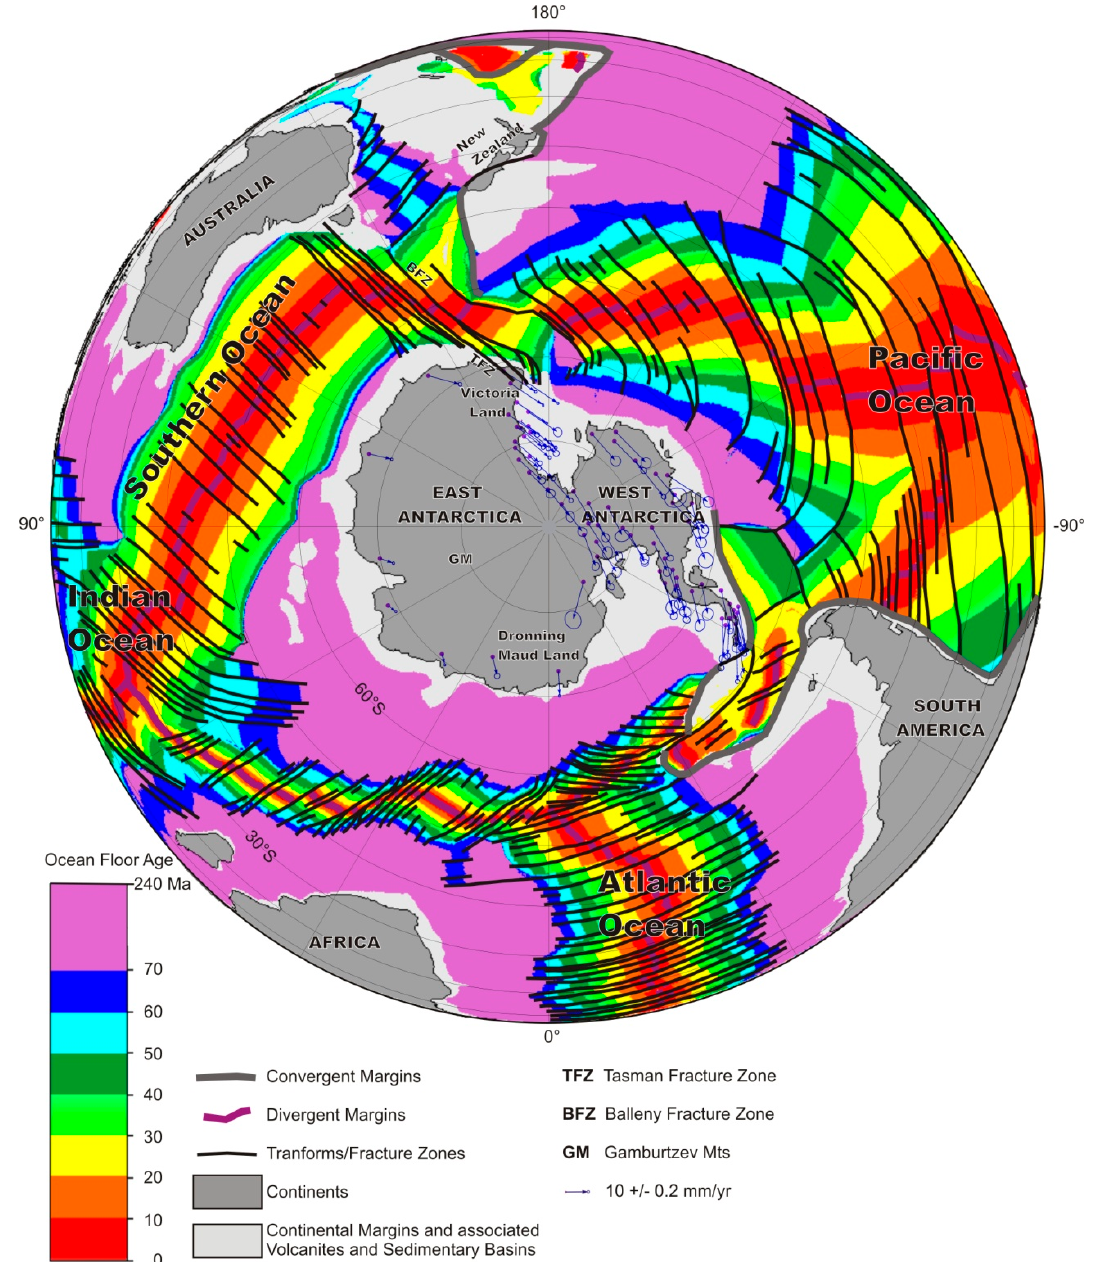
Figure 14. Absolute velocities of the Antarctica continent within the frame of the Southern Hemisphere plate tectonics focused in the last 70 Ma (orthographic projection, ocean floor age data from [59]). The clockwise rotation of Antarctica is associated with the ocean expansion nearly always at high angle with the continent margins. This contrast with the geodynamic in the Victoria Land, where, related to the eccentric position of the rotation pole with respect to Antarctica, the Tasman and Balleny fracture zones have entered within the continent with an extra right-lateral displacement since the Upper Cenozoic [21,23,24].